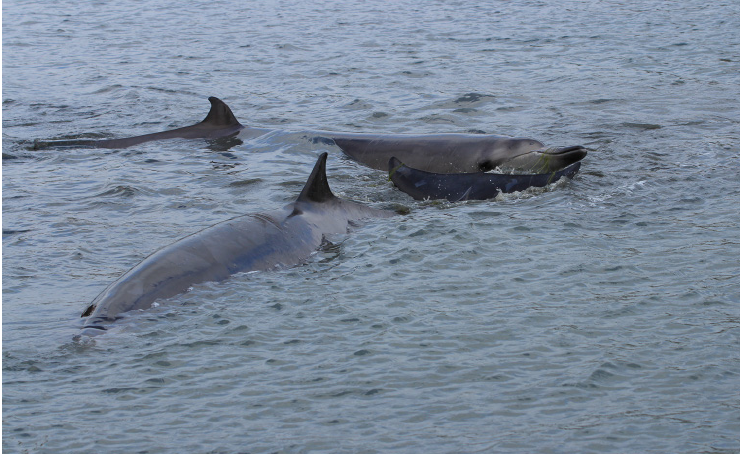
Figure 5. Two of the three Sowerby’s beaked whales ( Mesoplodon bidens ) that were found in shallow waters of the Åbyfjord on the Swedish west coast in 2019. Photo: Lena Lundin.